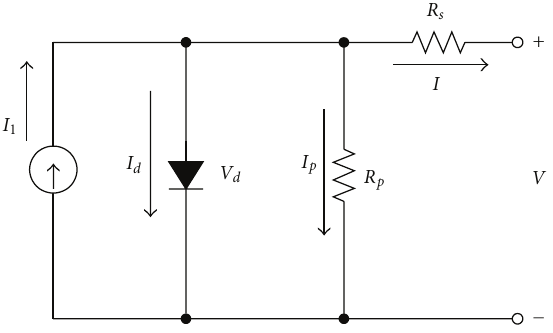
Figure 1: Equivalent circuit of a solar